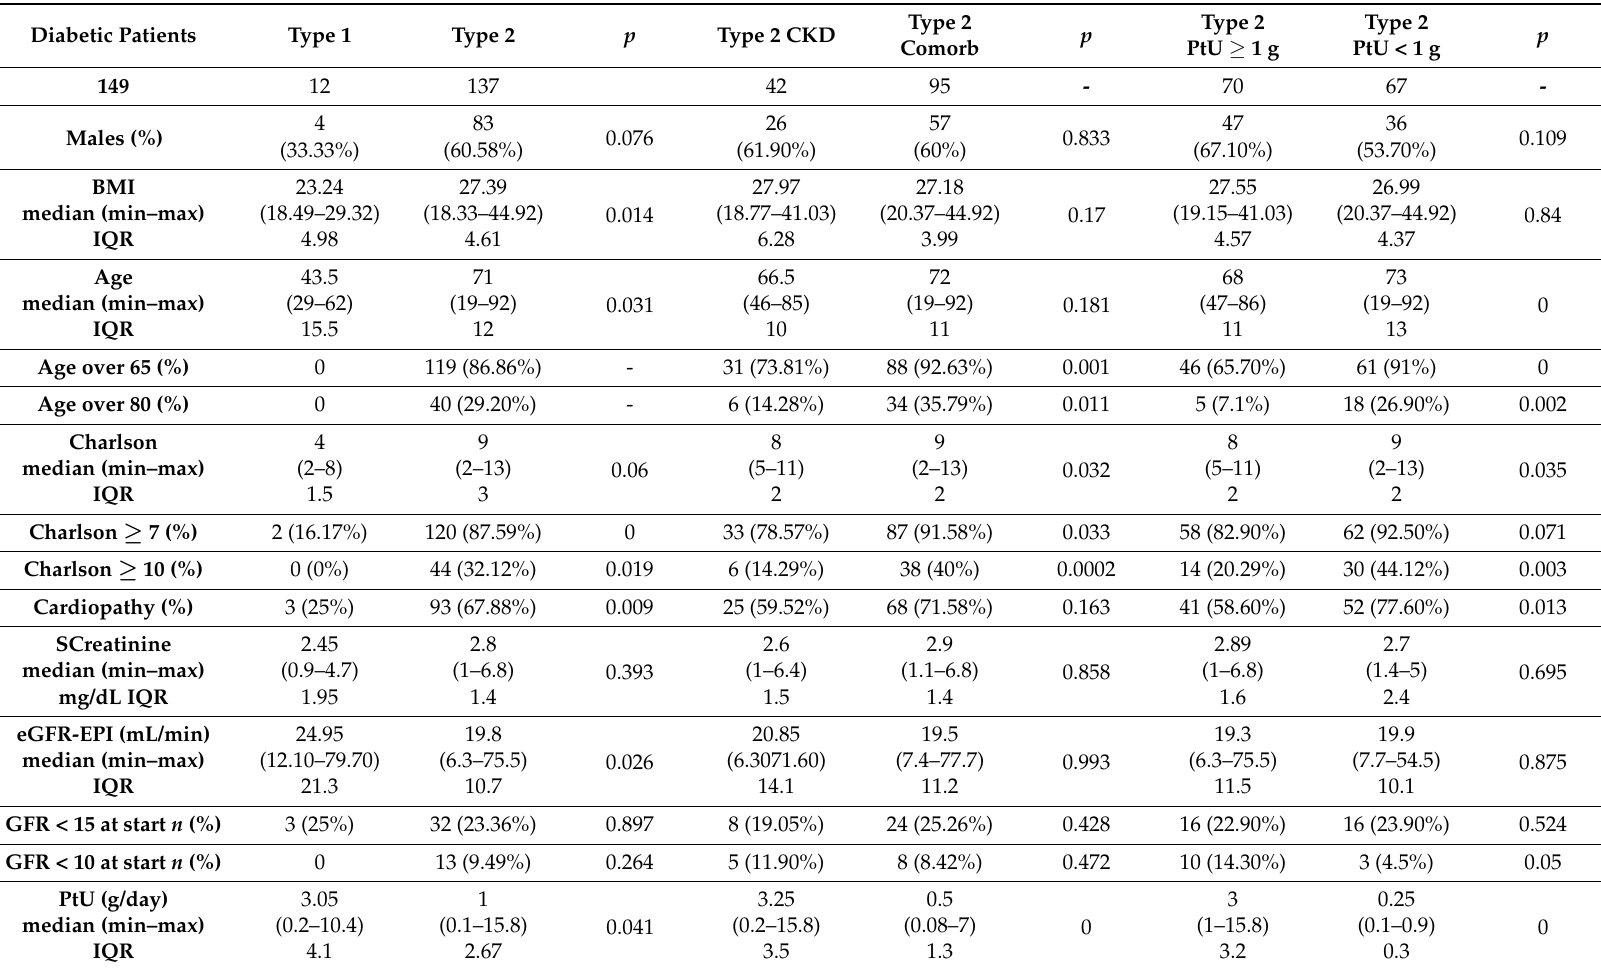
Table 5. Diabetic patients divided according to type of diabetes and diabetes as comorbid factor or kidney disease. Diabetic